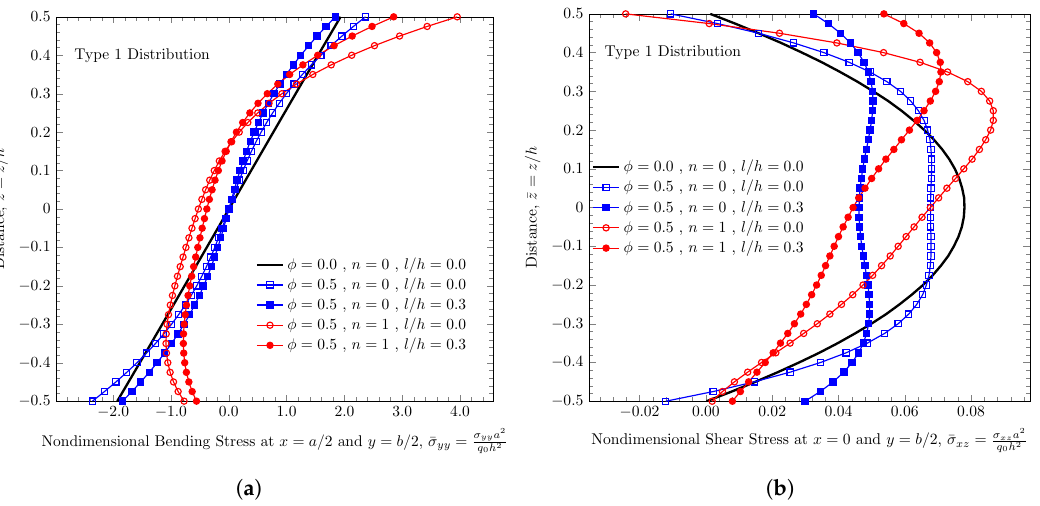
Figure 6. Bending stresses (¯ σ yy ) distribution ( a ) and transverse shear stresses (¯ σ xz ) distribution ( b ) through plate thickness.